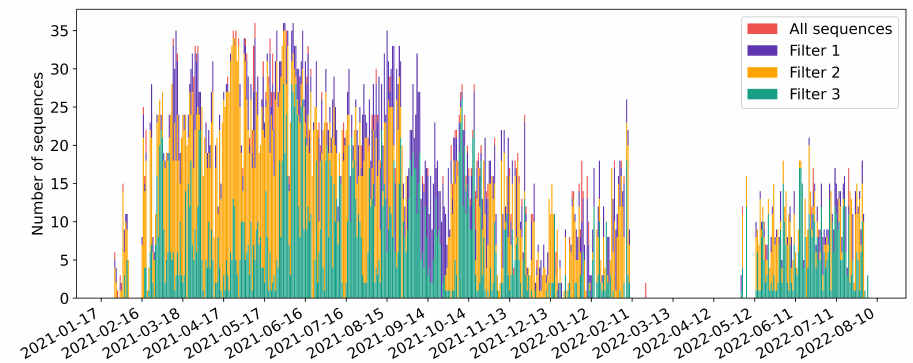
Figure 2. Number of valid sequences taken each day (“All sequences”), and the remaining sequences after removing the spectra that do not satisfy the following filters: (1) Filter 1: L u ( λ ) / E d ( λ ) between 800 and 950 nm > 0.025 sr − 1 ; (2) Filter 2: (cid:101) ( 720,780 ) > 0.005; and (3) Filter 3: removing negative reflectance data in the 400–900 nm range. Note that instrument was in maintenance and recalibration in February–April